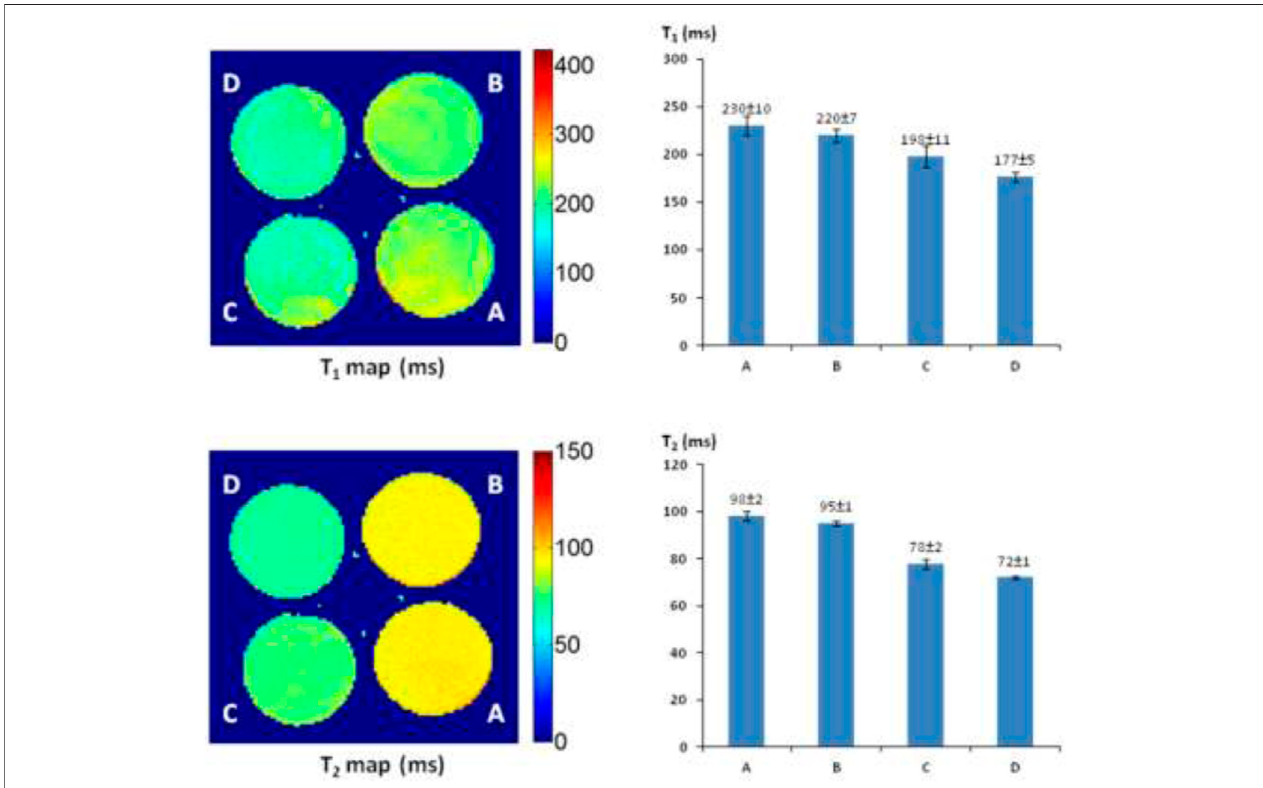
FIGURE 6 | 1 H-MRI detection of β -gal activity. 1 H-MRI acquisition: using the same parameters as in Figure 2 , (A) alizarin 1,2-di- O - β - D -galactopyranoside AZ-2 (9.0 mM) and FAC (15.0 mM); (B) alizarin 1,2-di- O - β - D -galactopyranoside AZ-2 (4.0 mM), FAC (15.0 mM), and β -gal (E801A, 5 units); (C) alizarin 1,2-di- O - β - D -galactopyranoside AZ-2 (6.0 mM),FAC(15.0 mM),and β -gal(E801A,5units); (D) alizarin1,2-di- O - β - D -galactopyranoside AZ-2 (9.0 mM),FAC(15.0 mM),and β -gal (E801A, 5 units) in 1:1 (V/V ′ ) DMSO/PBS (0.1 M, pH (cid:1) 7.4) at 37 ° C in 4